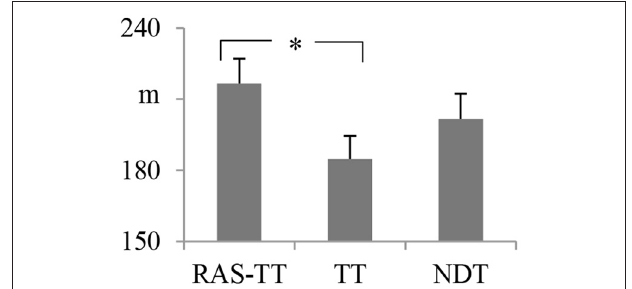
FIGURE 3 | Adjusted means of post intervention walking distance from the 3min walking time test with pre-intervention measures and time between stroke and study entrance as co-variates. Error bars indicate the standard error. *Statistically significant group contrast. ( p < 0.05). RAS-TT, rhythmic auditory stimulation with treadmill; TT, treadmill training; NDT, neurodevelopment treatment.